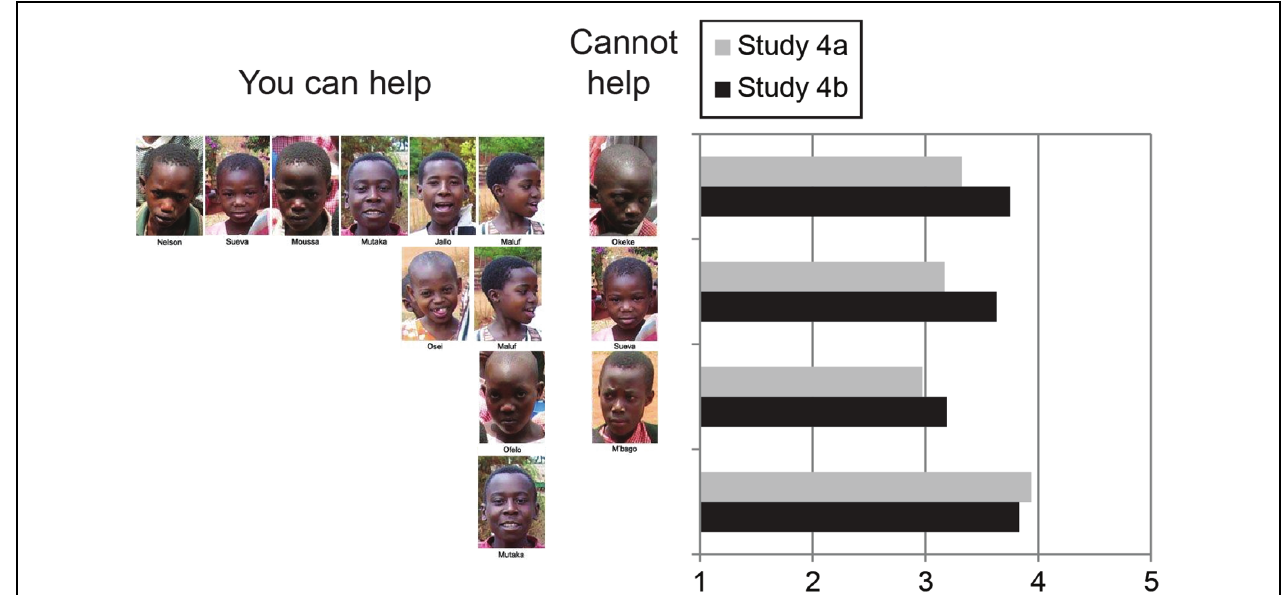
FIGURE 2 | Mean warm-glow ratings in within-subjects designs (Studies